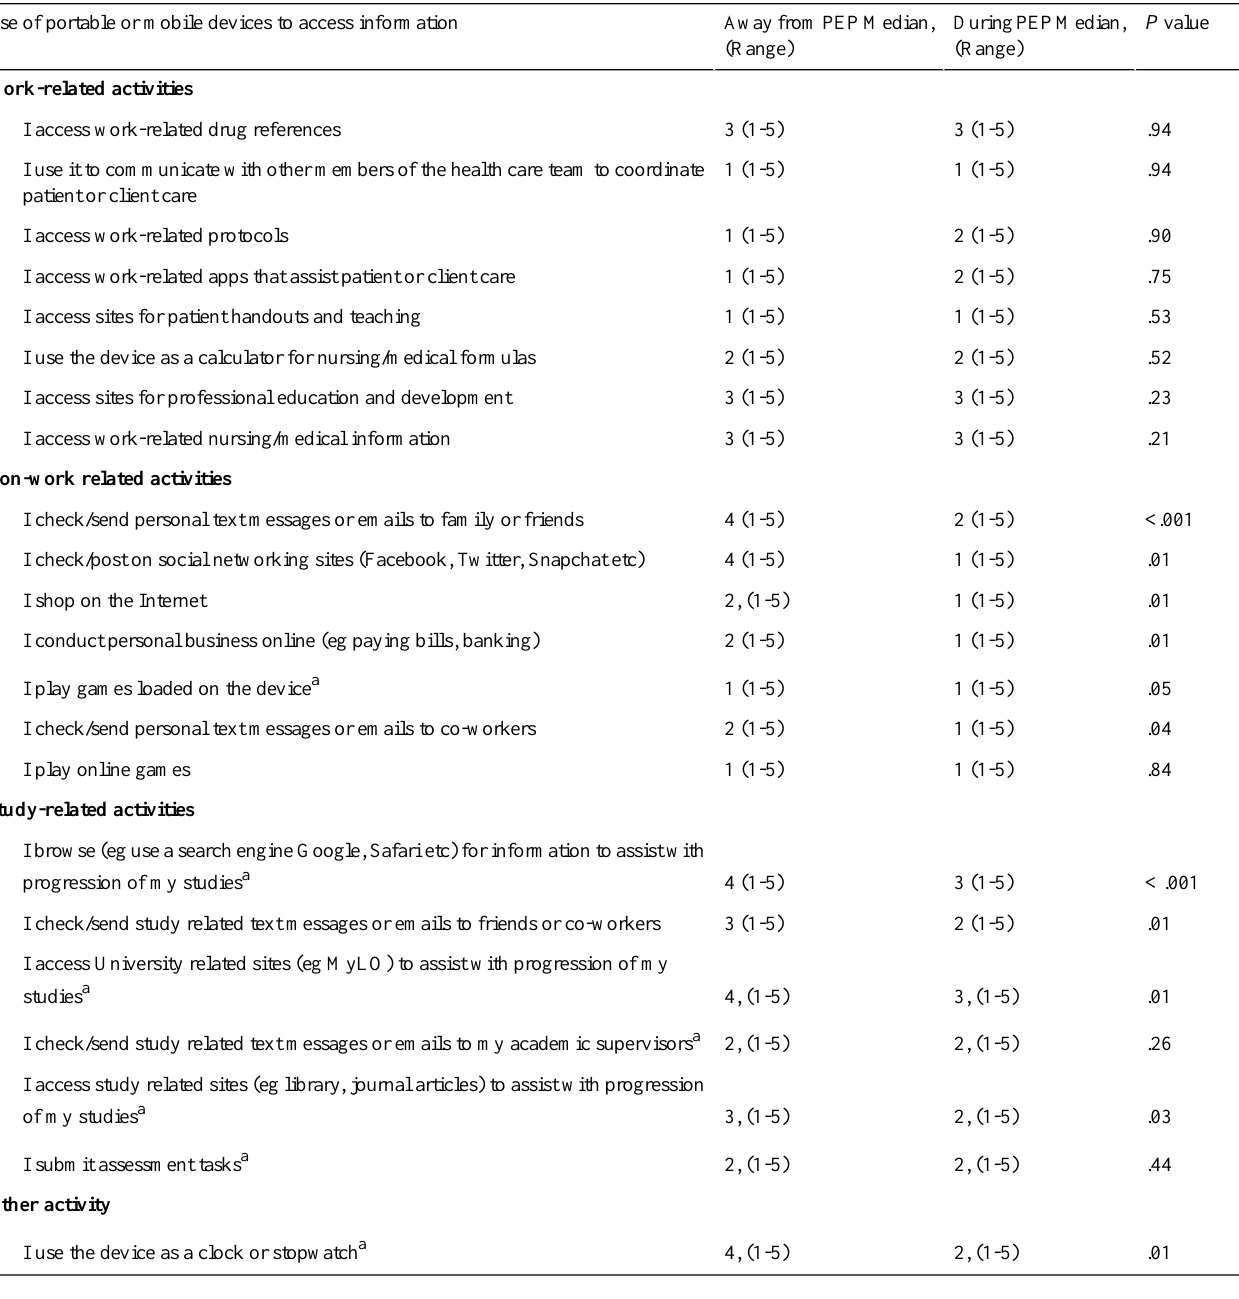
Table 2. Utilization of portable or mobile devices during work integrated